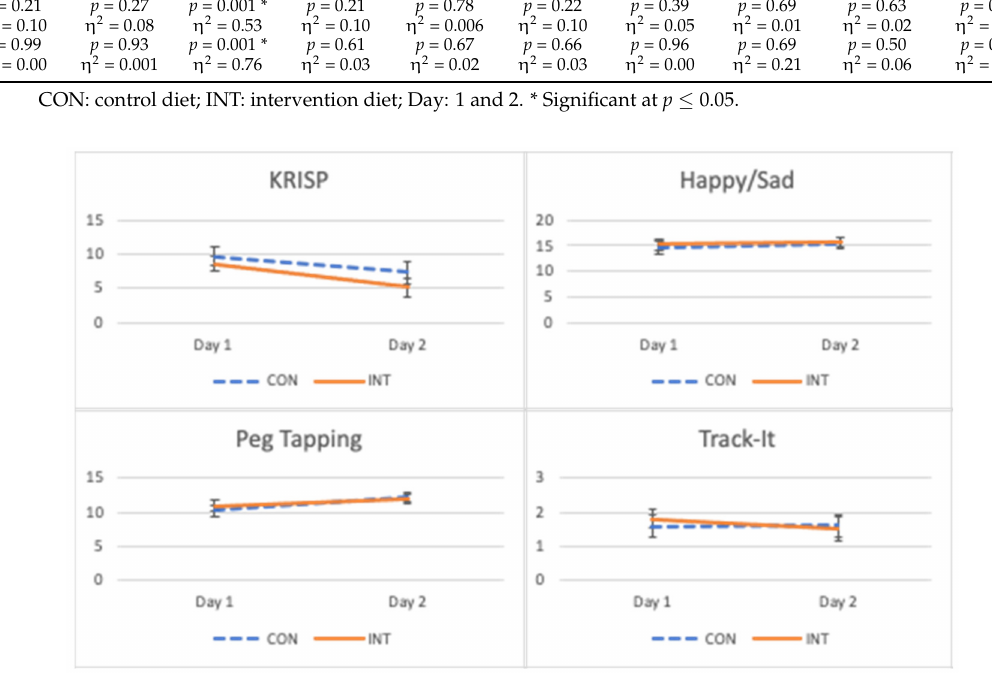
Figure 1. Estimated means and standard error graphed by condition (CON and INT) and day (1 and 2). CON: control diet; INT: intervention